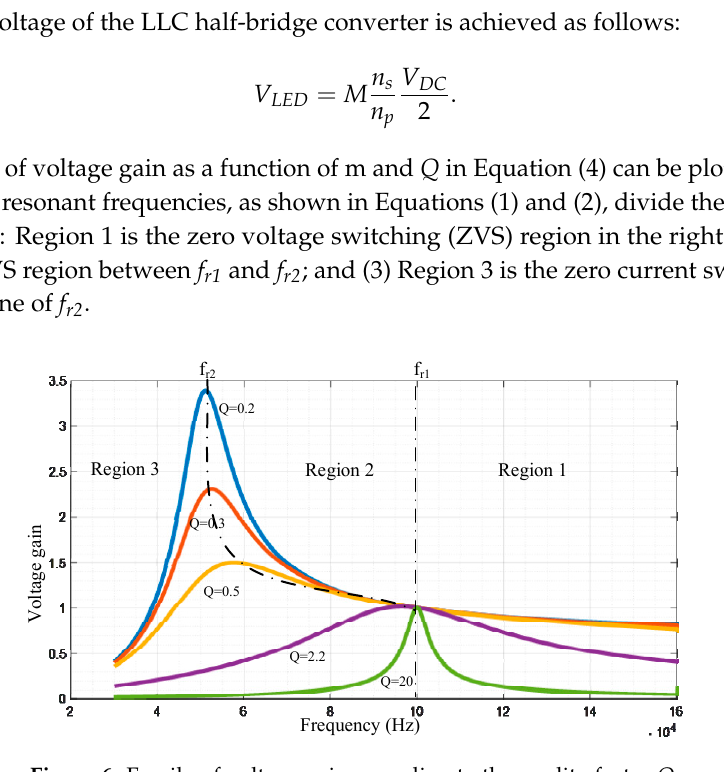
Figure 6. Family of voltage gain according to the quality factor Q .